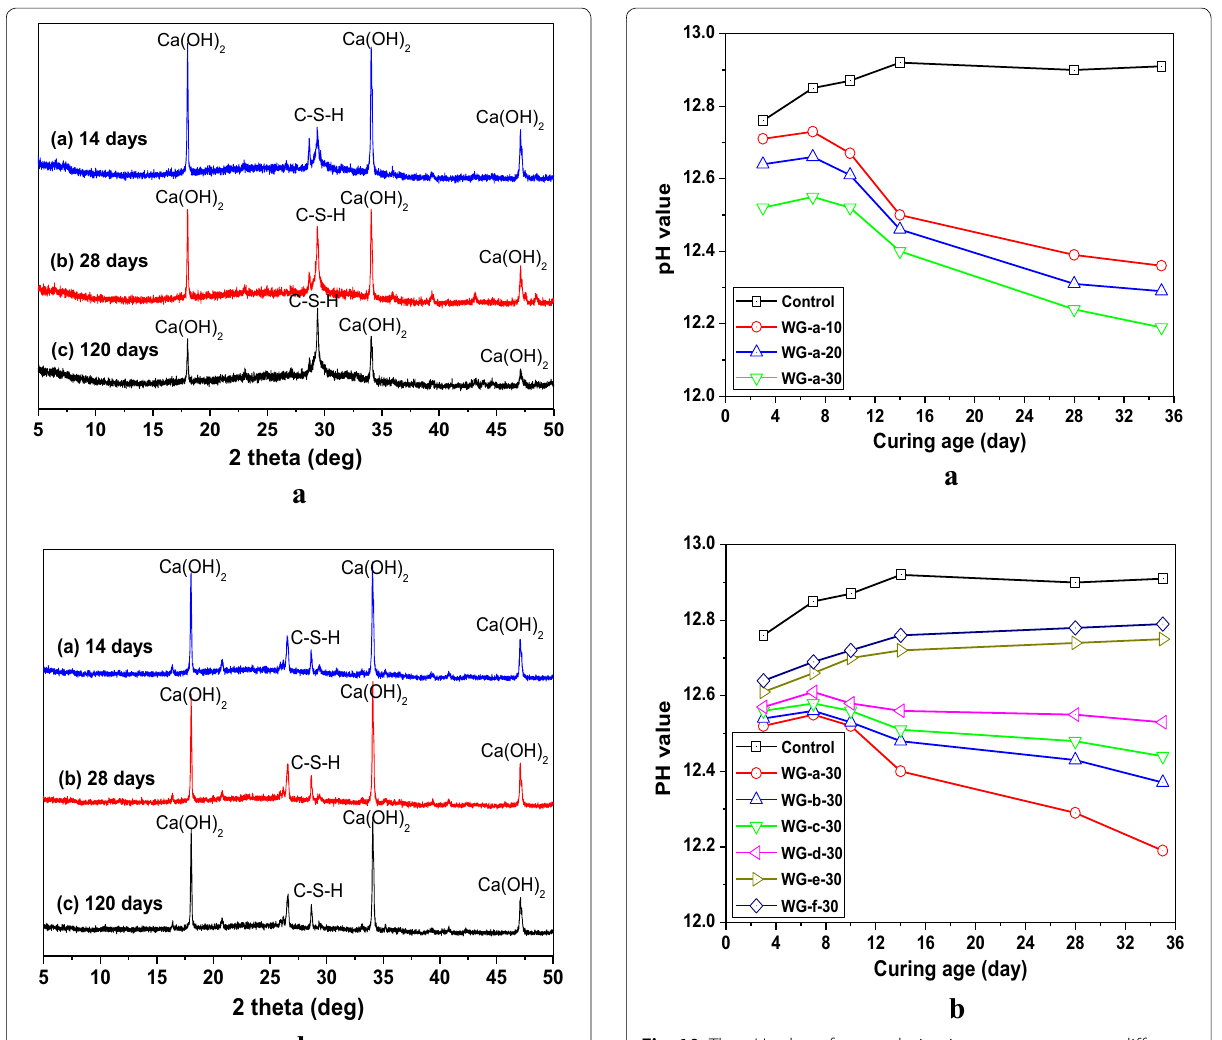
Fig. 10 The pH value of pore solution in cement mortars at different curing ages. a Different replacement ratios, b different particle